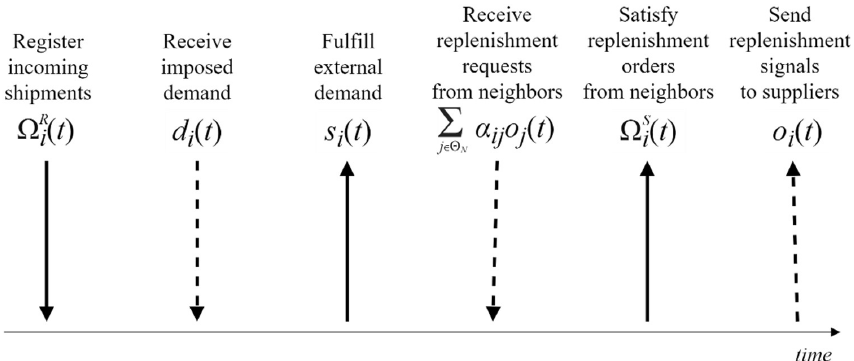
Figure 1. Operational sequence at a controlled node.